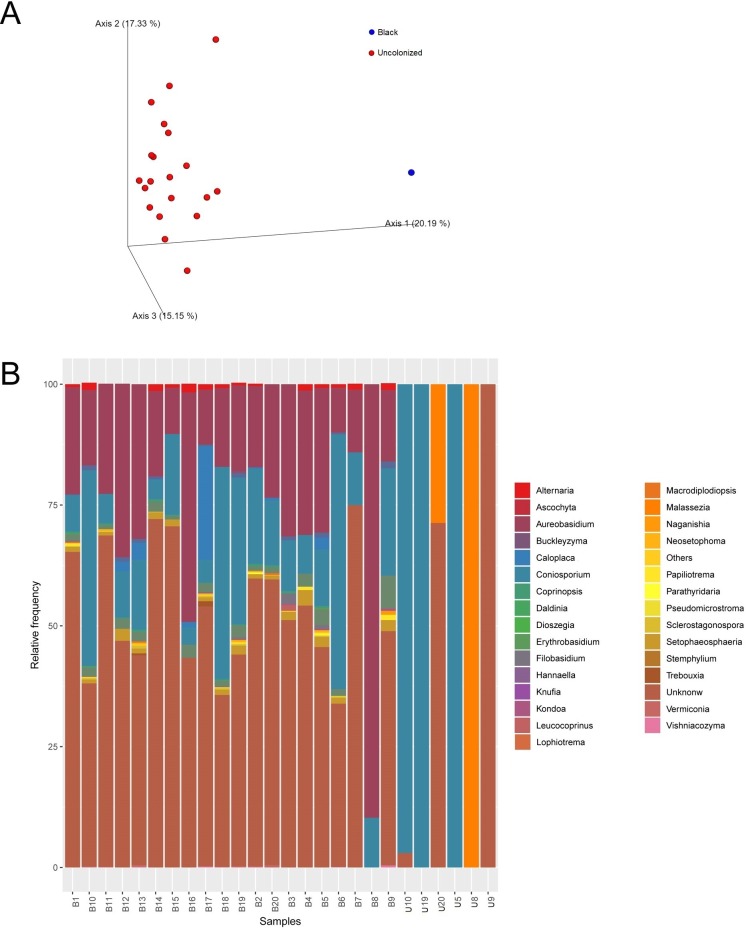
Statistics about ITS2 data.(A) Beta diversity represented by a Principle Coordinate Analysis Emperor plot on a Bray-Curtis distance matrix; (B) Stacked bar charts of the taxonomic profile at species level, low abundance taxa are lumped together in the “Others” category.